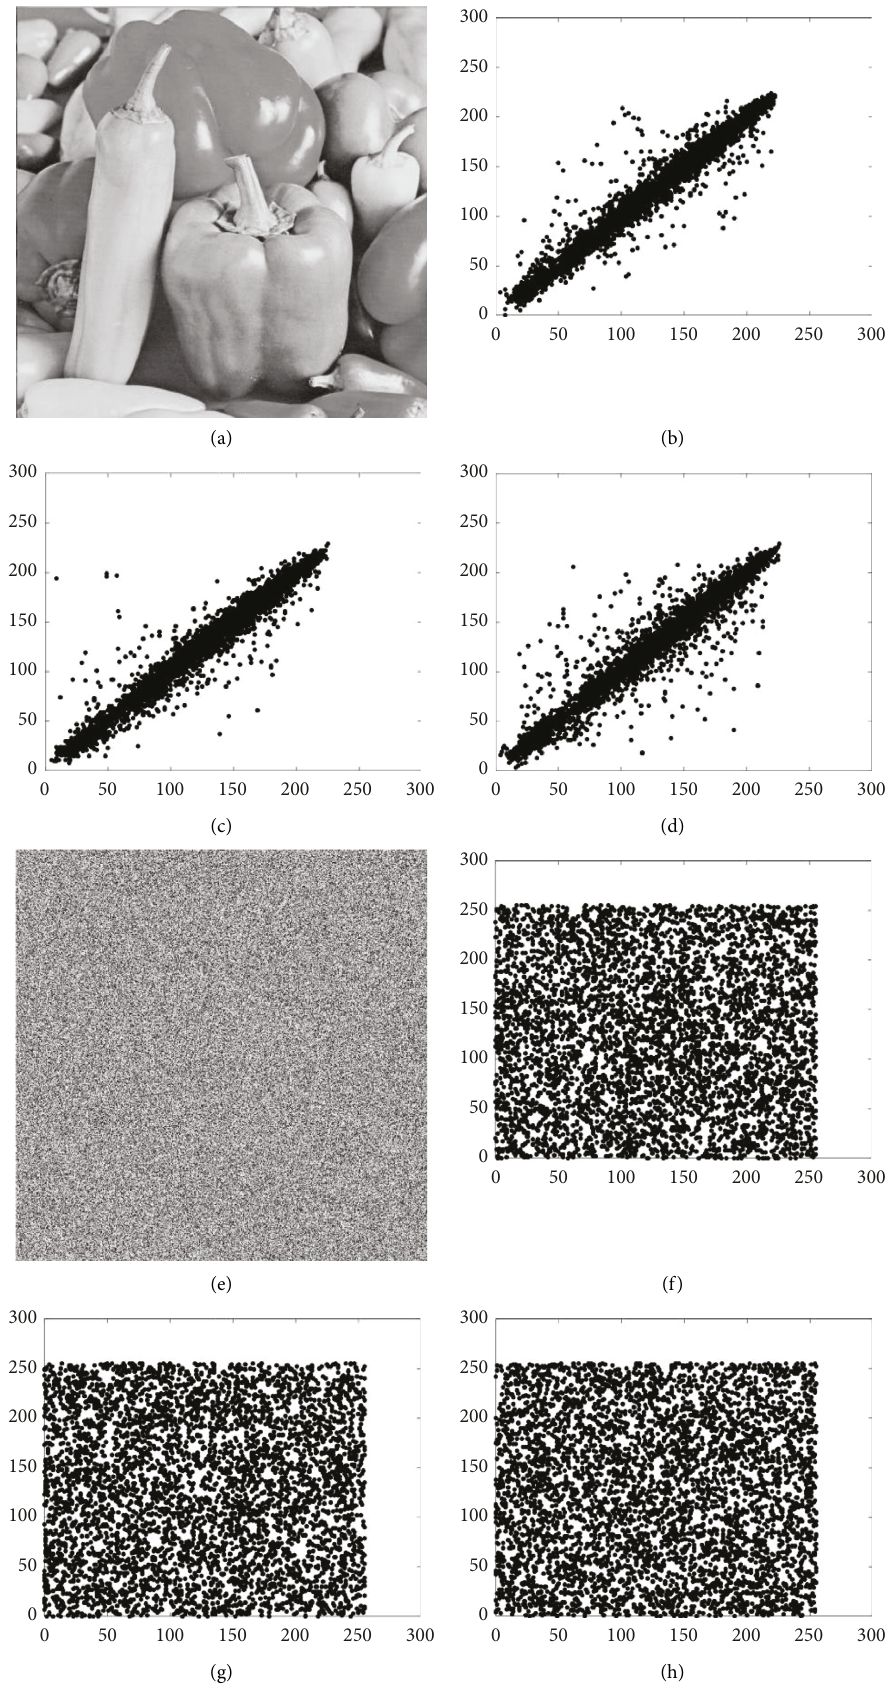
Figure 6: Correlation coefficients of the image of pepper (a) plain image; (b)-(d) horizontal, vertical, and diagonal correlation coefficients of the plain image; (e) encrypted image; (f)-(h) horizontal, vertical, and diagonal correlation coefficients of the encrypted